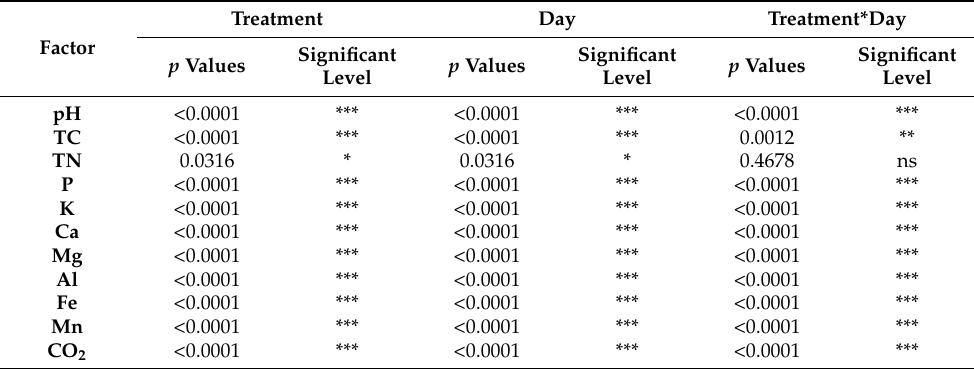
Table 3. Results of the repeated measures (ANOVA) analysis conducted with Generalized Liner Model(GLM) indicating the p values/* of the treatment, day, and treatment with day interactions of parameters.